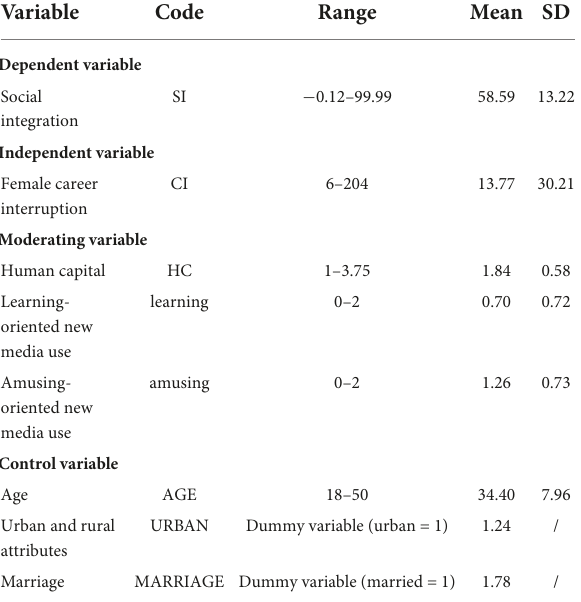
TABLE 3 Statistical description of